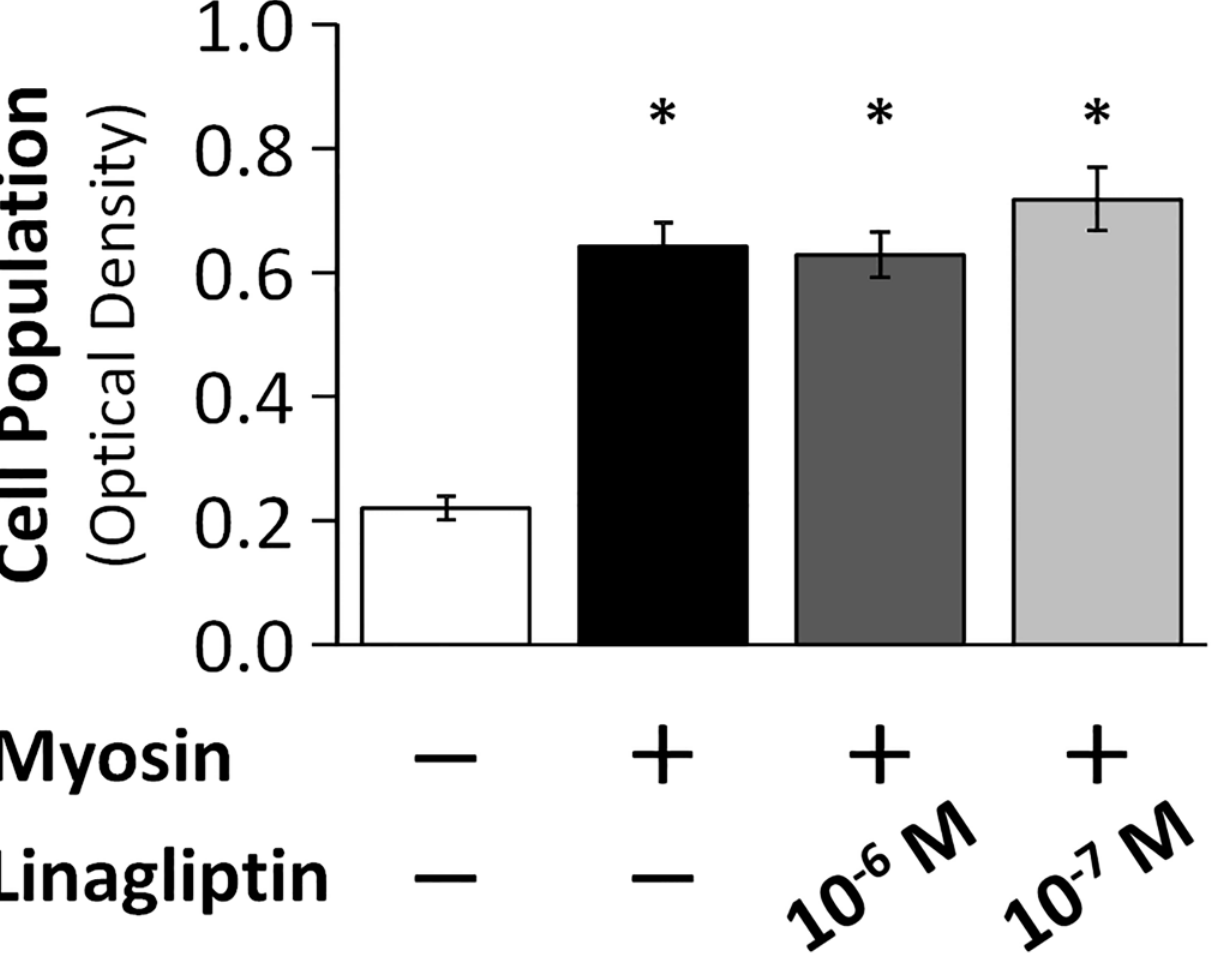
Fig 3. Results of lymphocyte proliferation assay. Cultures with spleen-derived lymphocytes obtained from EAM mice were incubated at 37°C with 5% CO 2 for 70 hours. Lymphocyte proliferation was evaluated. Treatment of a DPP-4 inhibitor did not affect antigen-induced spleen-derived lymphocyte proliferation. * P < 0.05 vs. Myosin-, Linagliptin-, Bonferroni comparison test. Values are mean ±